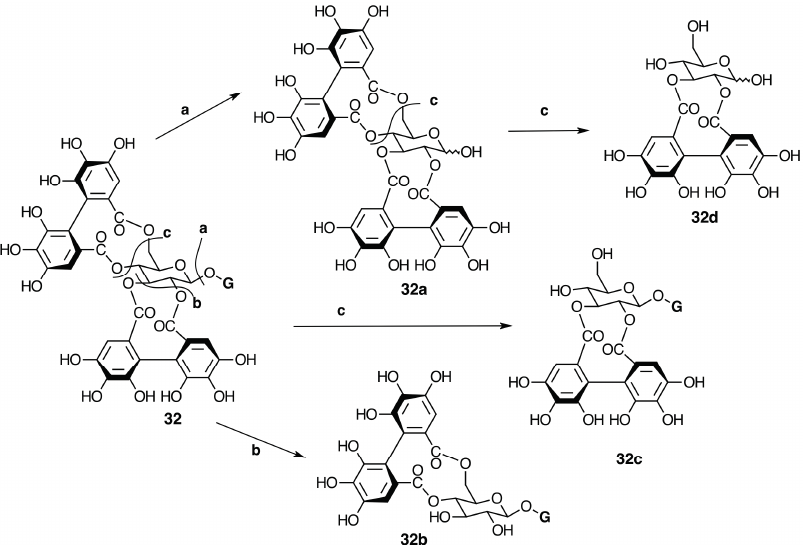
Figure 14. Biogenesis of casuarictin-type monomeric ellagitannins. Degalloylation ( a ) and de-HHDP-ation ( b , c ) of casuarictin ( 32 ).